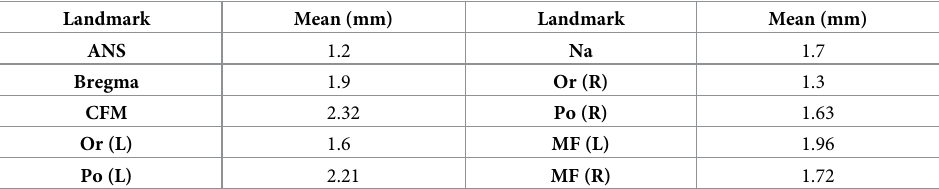
Table 1. Mean detection error for 10 reference landmarks. Most of the landmarks are annotated almost within clini- cal requirements.